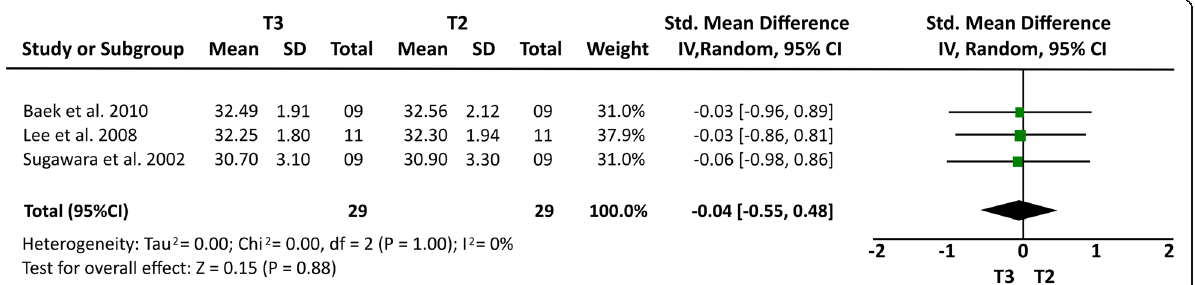
Fig. 5 Forest plot of LAFH difference between T2 and T3 in patients who used TAD ’ s for molar intrusion after 1-year follow-up. 95% confidence interval and 95% prediction interval